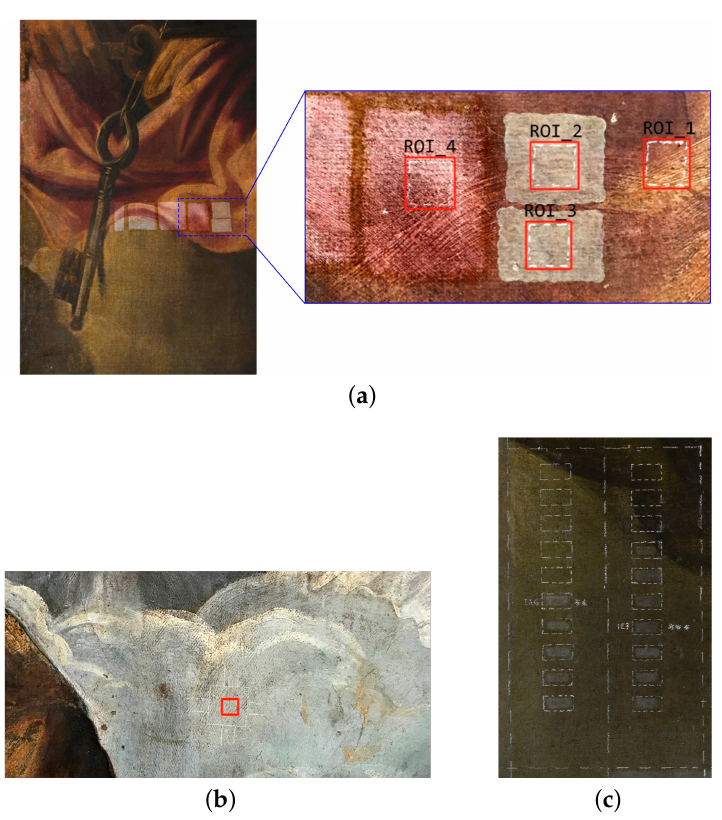
Figure 1. Pictures of the surface samples with the cleaning test detailed in Table 1. Experiment 1: ( a ) Multiple ROIs of red lake on St. Peter’s cloak with the treatment steps, original non-treated (ROI 1), laser (ROIs 2 and 3), laser–chemical (ROI 4). ( b ) Single ROI of azurite mixed with calcium carbonate, lead white, red ocher, and carbon black. Experiment 2: ( c ) ROIs labeled with stars treated with different solvent mixture at different